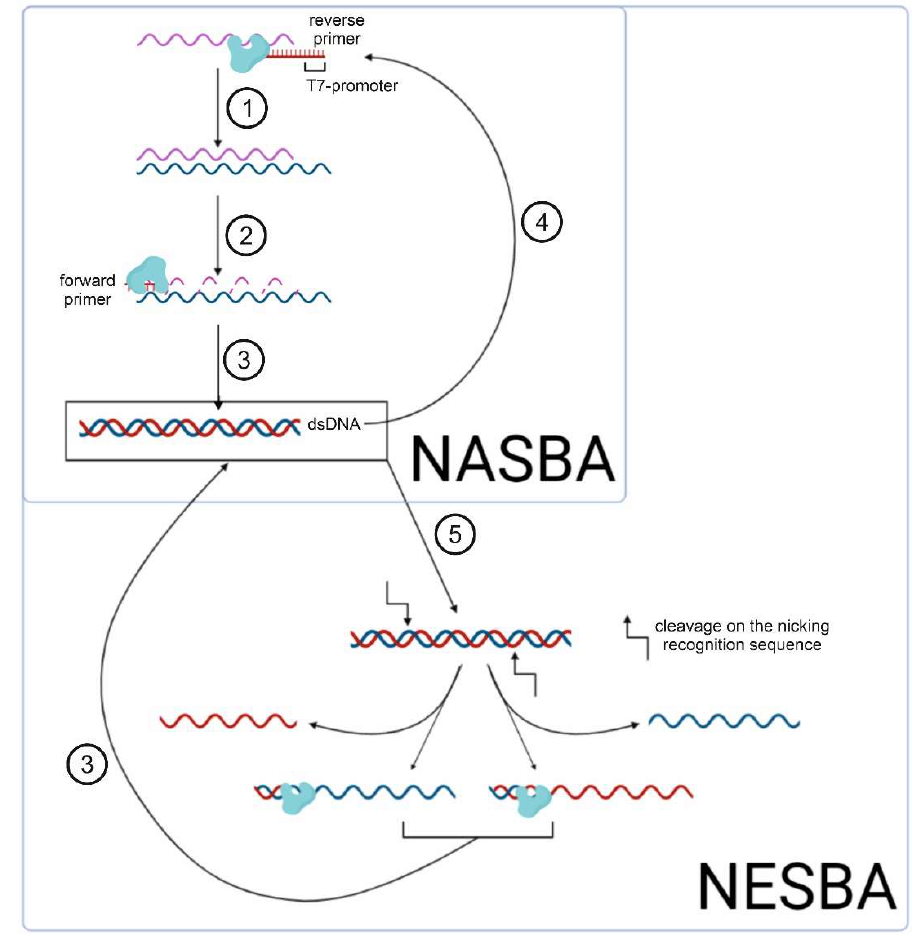
Figure 2. Scheme of isothermal amplification NASBA and its modification NESBA, including the following steps: (1) reverse transcription of the initial RNA fragment by the AMV reverse transcriptase (shown in the figure); (2) RNase H-mediated cleavage of these RNAs; (3) synthesis of dsDNA as a matrix for (4) subsequent in vitro transcription; (5) nicking of the dsDNA with its subsequent amplification.